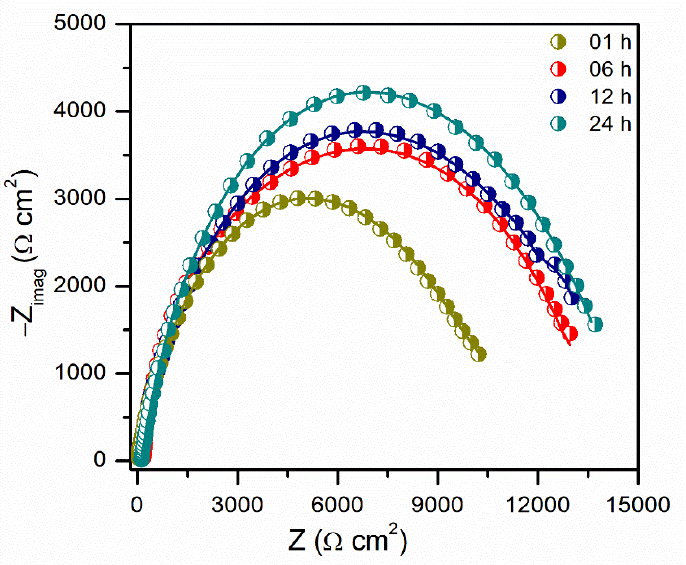
Figure 7. Nyquist plot obtained for EN3B mild steel immersed in 3.5% NaCl solution (pH 1.5) in the presence of 10 mM Py8 at different immersion